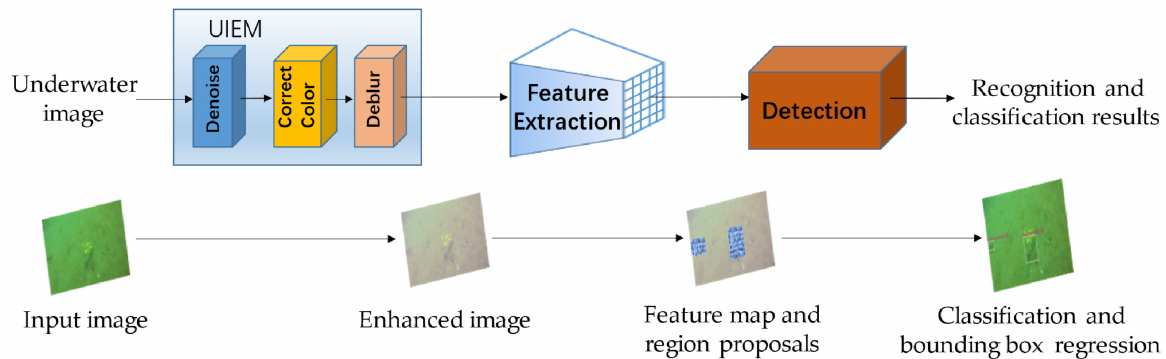
Figure 1. The overall structure of the proposed